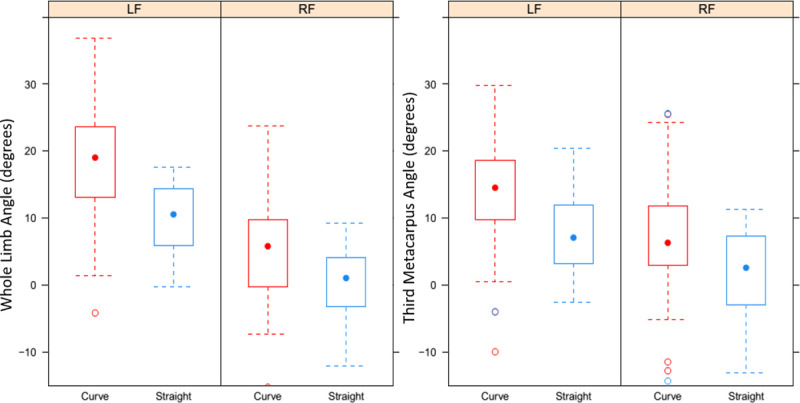
Effect of curve running on limb inclination.Boxplots show the mean (dot) and quartiles (box) of absolute angles for the whole limb and third metacarpus a curve (red) and on the straight (blue) for inside (LF) and outside (RF) forelimbs.